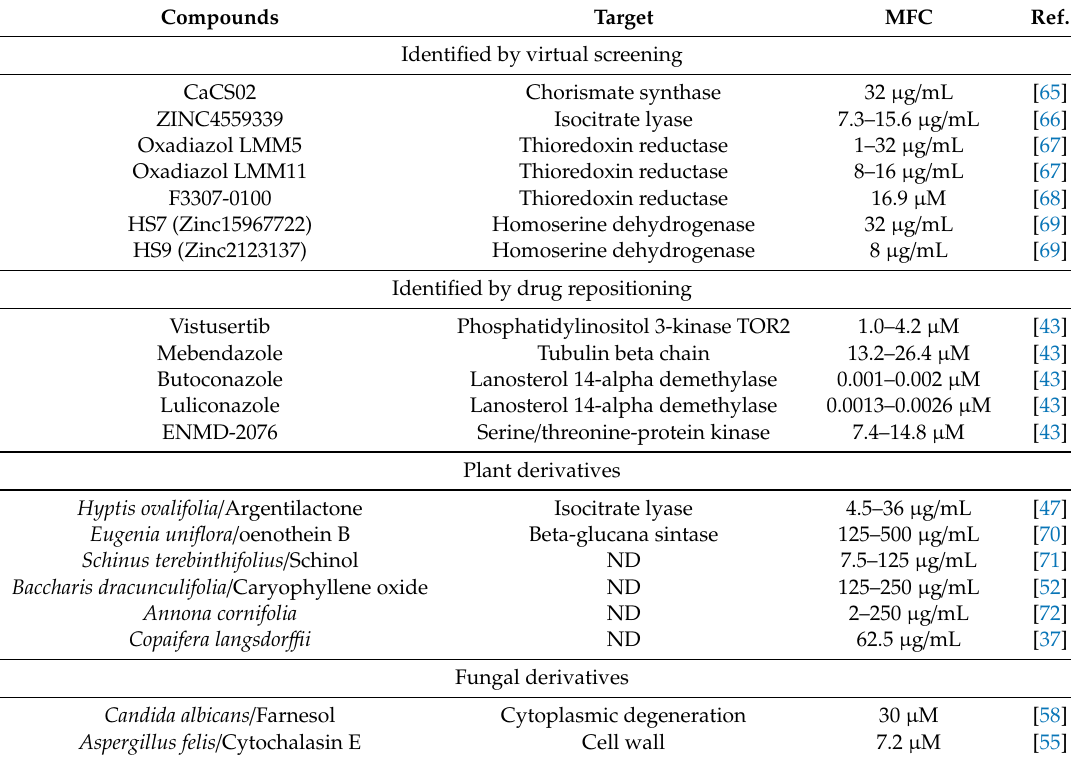
Table 1. Most potent fungicidal